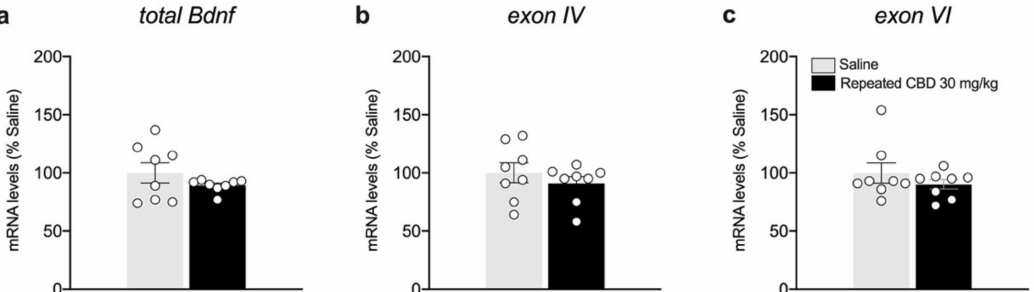
Figure 6. Effects of repeated CBD exposure on Bdnf gene expression levels in the mPFC. Rats were treated with repeated injections of CBD 30 mg/kg for seven days and killed twenty-four hours after the last treatment. Total Bdnf ( a ), exon IV ( b ), and exon VI ( c ) mRNA levels in mPFC are expressed as percentages of saline-treated rats. Bar graphs represent the mean ± SEM from eight independent determinations for each experimental group. Unpaired Student’s t -test. Saline n = 8, CBD 30 mg/kg n = 8.